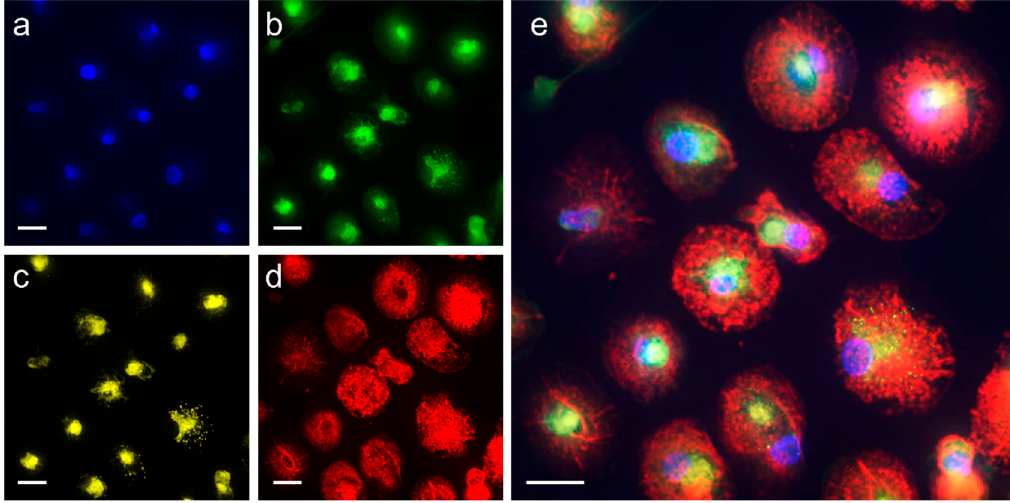
Figure 2. Live cell microscopy of primary human macrophages in microgravity with the confocal laser spinning disk fluorescence microscope FLUMIAS. Primary human macrophages stained with the live cell dyes: ( a ) Nuclear Violet for nuclei; ( b ) Calcein for the cytoplasm; ( c ) LysoBrite for lysosomes; and